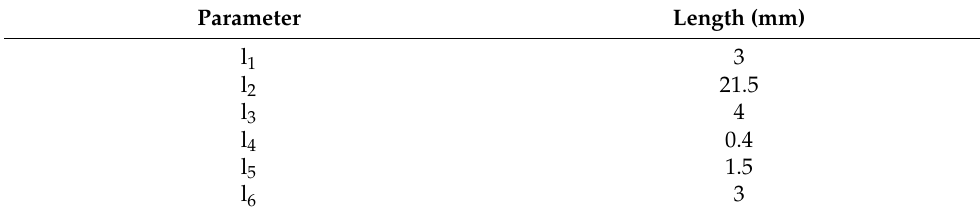
Figure 7. Illustration of EGaIn soft sensors used for grip force monitoring. ( a ) Definition of design parameters controlled in manufacture of EGaIn soft sensors. ( b ) Soft sensors with bumps (left) and without bumps (right) following manufacture. Table 1. Design parameters for manufacture of EGaIn soft sensors.